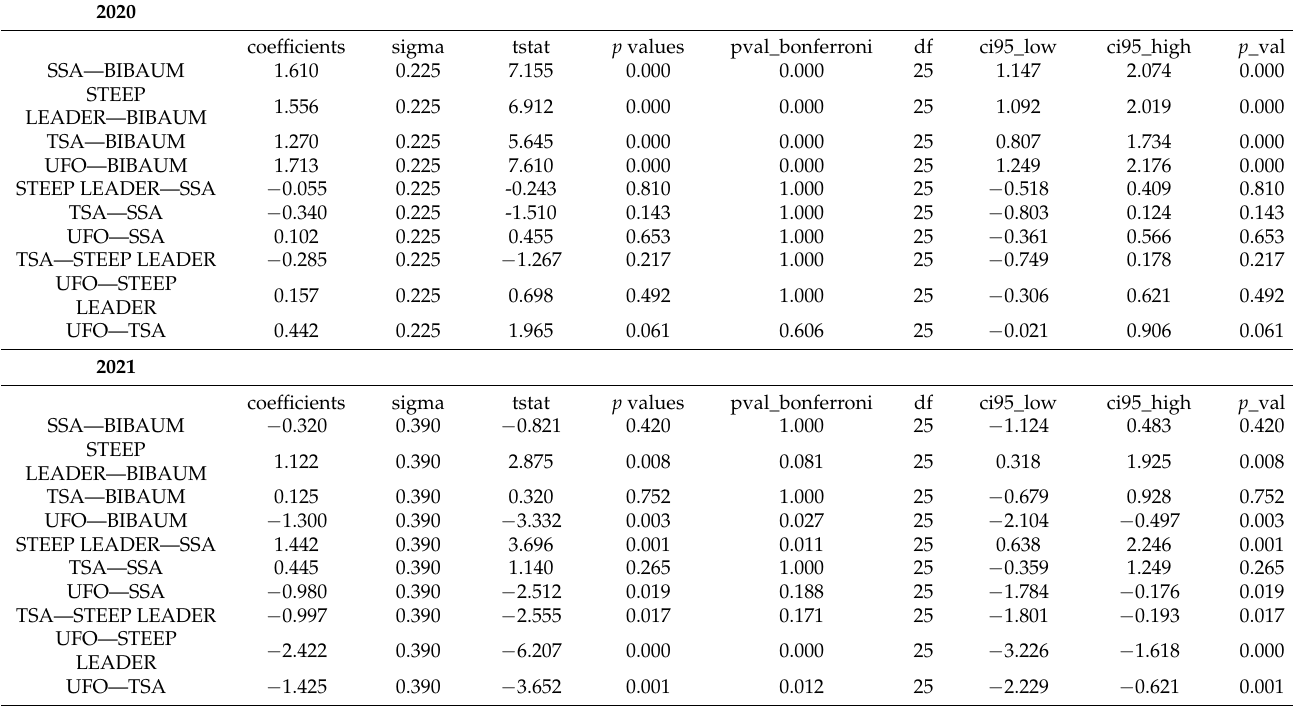
Table A6. Colour